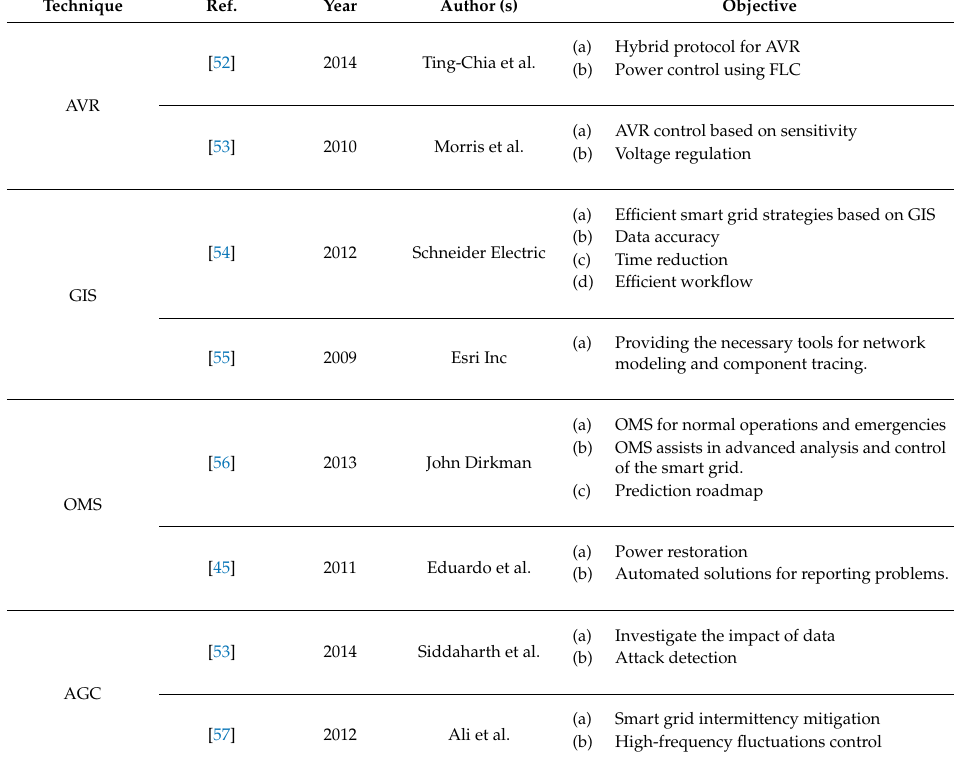
Table 3. Smart grids technologies and applications at a glance